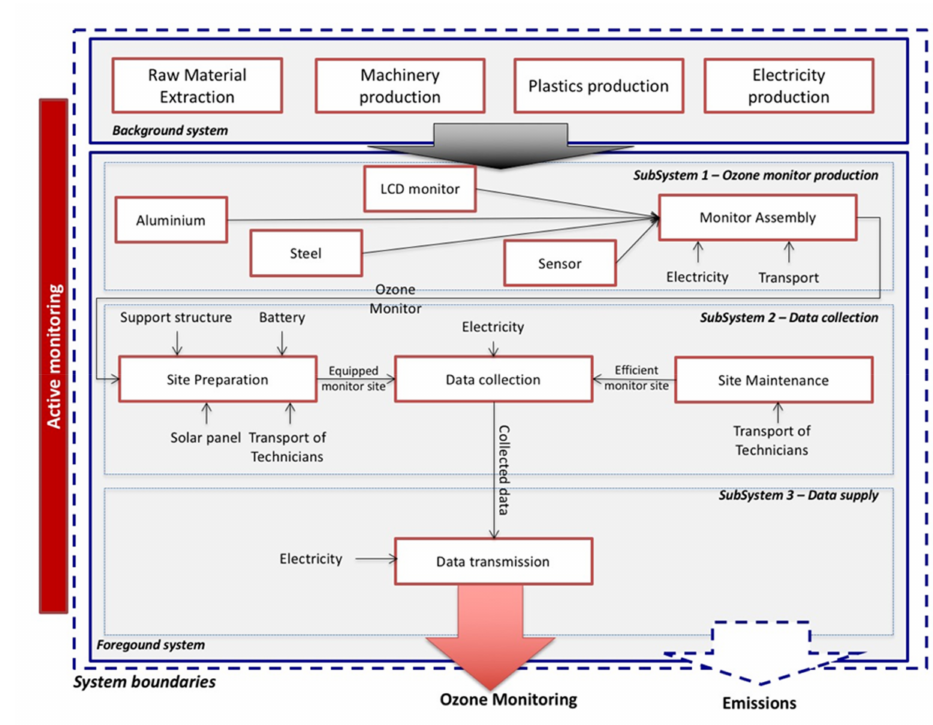
Figure 2. Flow chart and system boundaries for active ozone monitoring in a forest.